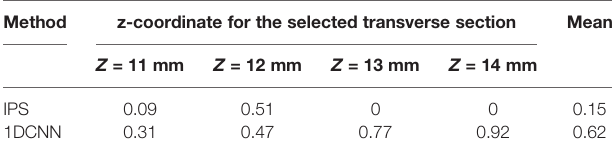
TABLE 4 | Quantitative results of Dice for in vivo BLT reconstruction. Method z-coordinate for the selected transverse section